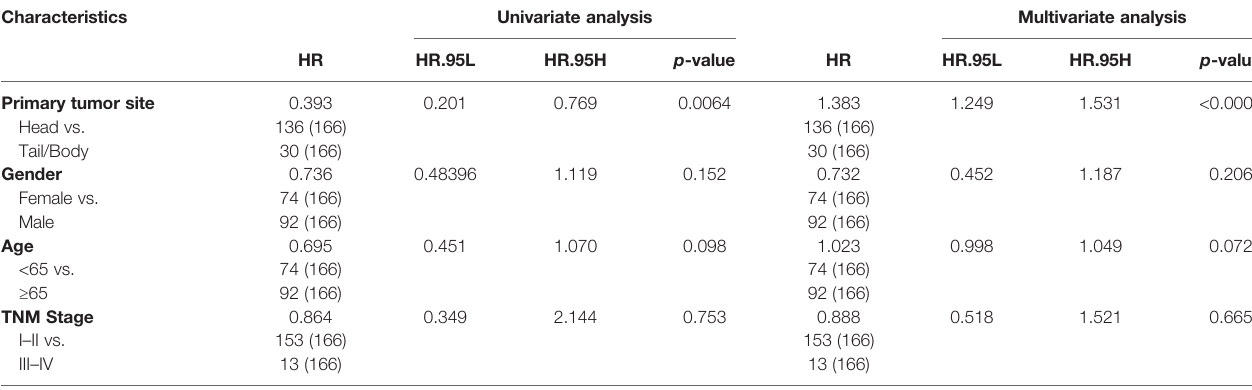
TABLE 2 | Association of overall survival with clinicopathological factors and tumor anatomical location of pancreatic cancer patients in TCGA-independent validation cohorts.